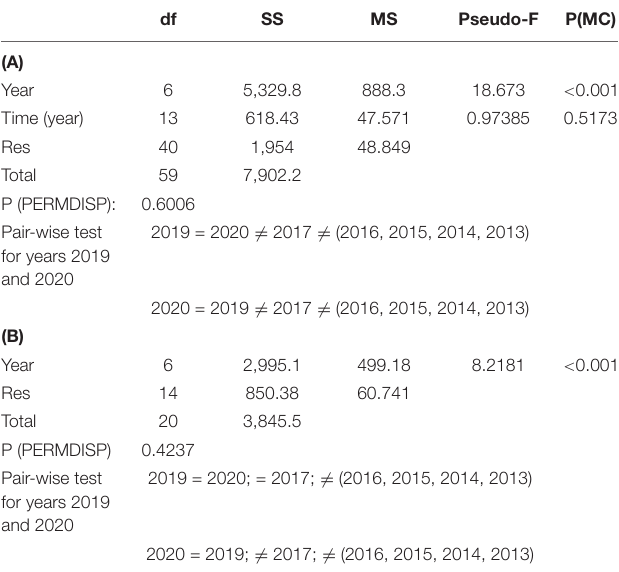
TABLE 1 | PERMANOVA and PERMDISP (for the factor “Year”) results for SBPQ station coverage data (2013–2020) (A) considering intra-annual variability (i.e., all seasons) and (B) only winter